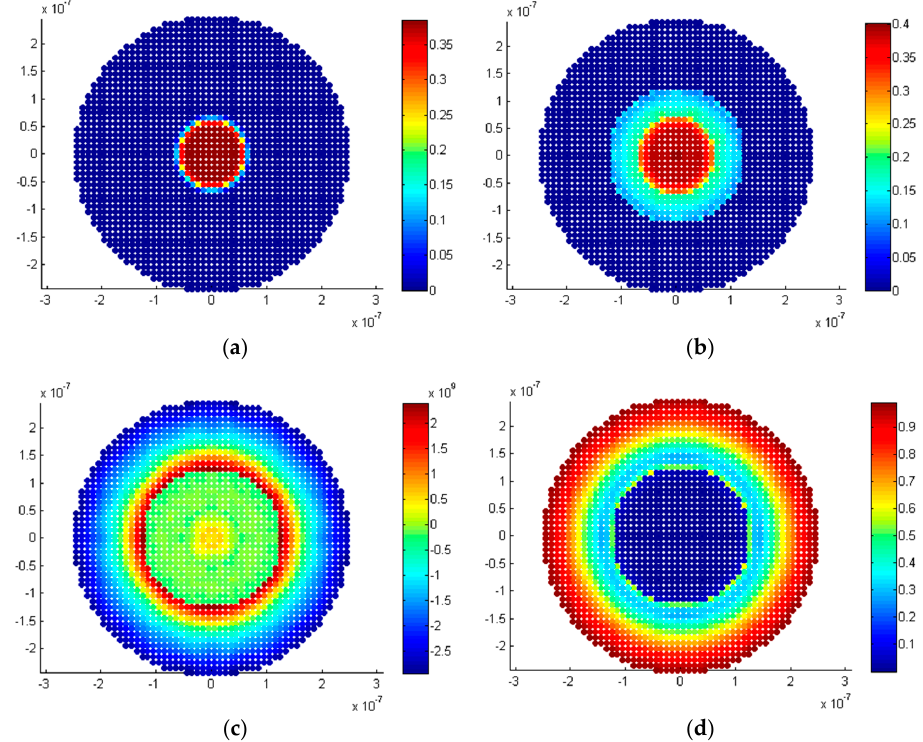
Figure 8. Result plots of the cylindrical anode with a single horizontal crack in the x - y mid-plane (crack surface plane): ( a ) initial damage; ( b ) damage after deformation; ( c ) hydrostatic stress; and ( d ) lithium ion concentration.